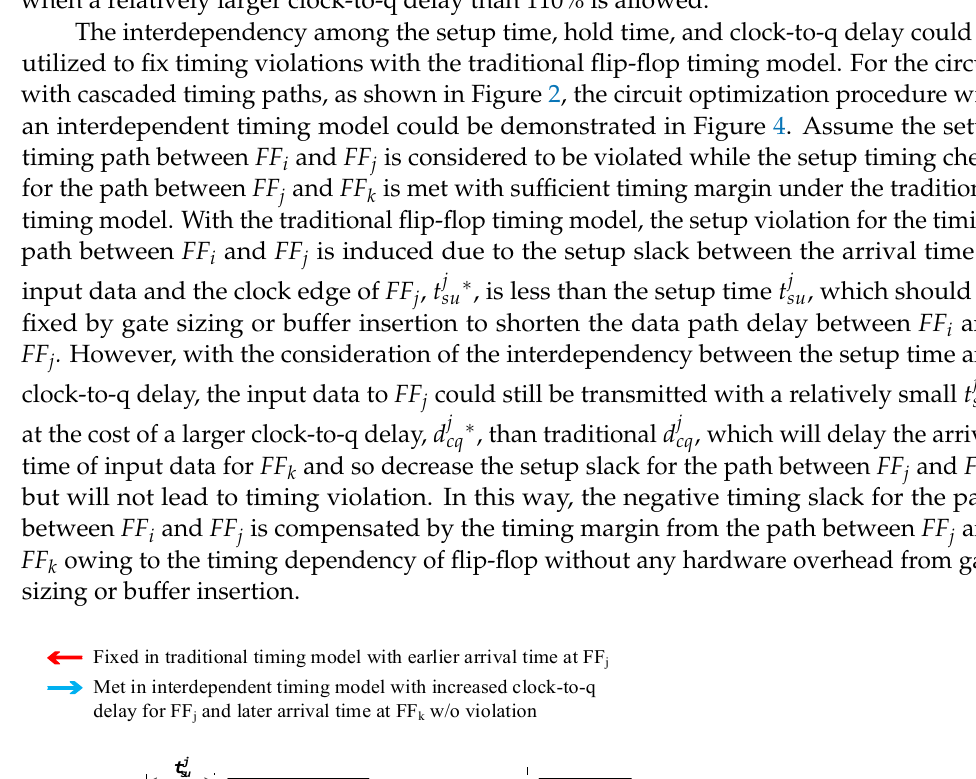
( b ) Figure 5. Setup–hold time curves under 40 nm proces s in ( a ) STV region, 1.1 V, 25 °C, TT corner; ( b ) NTV region, 0.6 V, 25 °C, TT corner. 3. Interdependent Timing Model Characterized by ANN In this section, the effective coverage for setup time and hold time in the NTV domain is determined by SPICE simulation and restricted in a hexagonal region in the two ‐ dimen ‐ sional setup–hold time space. With the carefully selected features, the interdependent clock ‐ to ‐ q delay is predicted by an ANN model, which is integrated into the conventional STA flow to update the timing slack by taking the interdependency of the timing con ‐ straint of flip ‐ flops into account. 3.1. Selection of Effective Coverage Due to the much wider effective coverage for setup time and hold time of flip ‐ flops, as demonstrated in Figure 5, the simulation range should be carefully selected to cover the dominant area for the interdependent timing constraint for flip ‐ flops under specific clock transition, data transition, and load capacitance. Noticing that the flip ‐ flop remains in a stable region when the switch of data signal is far away before and after the active clock edge while falls into a metastable region when the switch of data signal is quite close to the active clock edge, the effective region of SPICE simulation is restricted in a